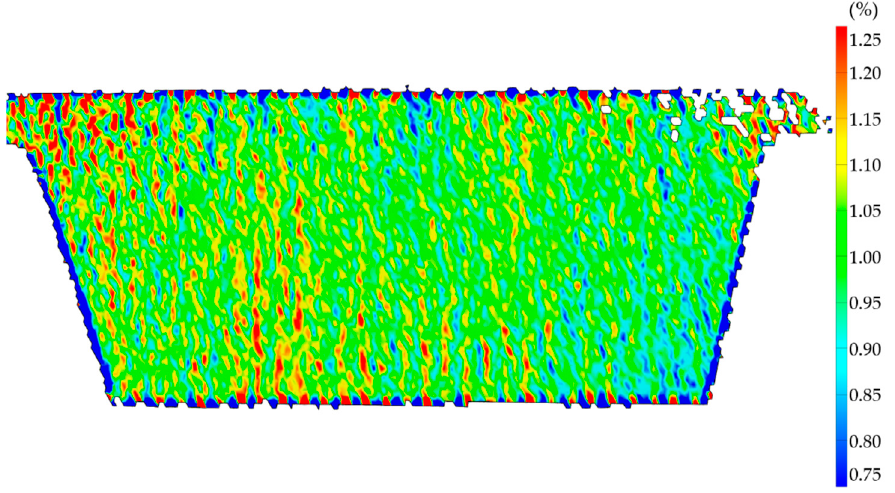
Figure 15. Specimen N14 tested along Y with low fiber misalignment in DIC at 1% average strain along 25 mm of center line.